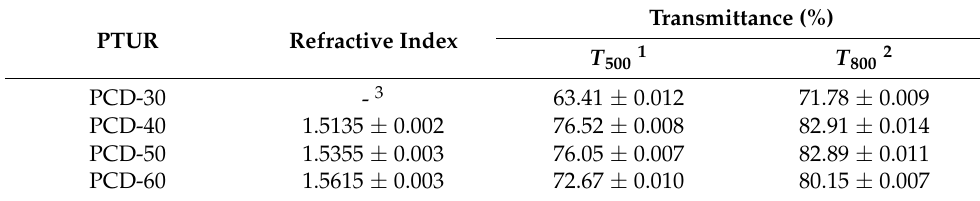
Table 8. Refractive index and transmittance of PTURs. PTUR Refractive